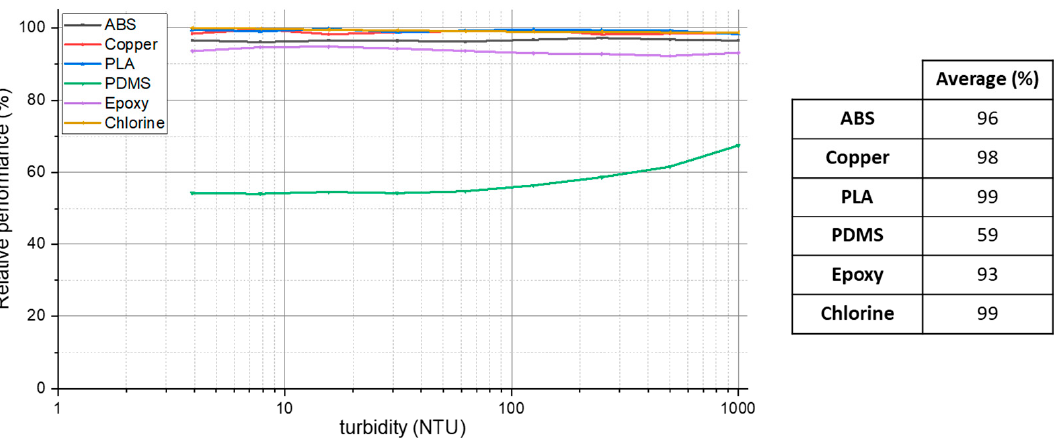
Figure 6. Relative performance between the first and the second calibration after the in situ experi- ment for the six anti-biofouling probes.